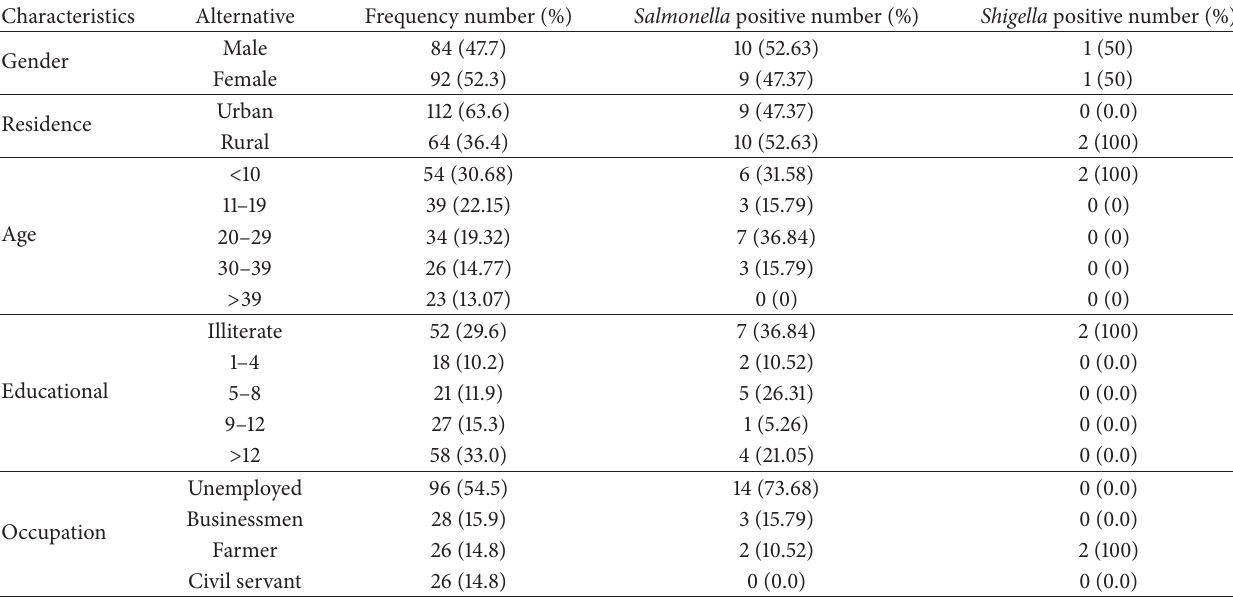
Table 2: Prevalence of Salmonella and Shigella against sociodemographic characteristics of the study participants, Jimma University Specialized Hospital, 2014.